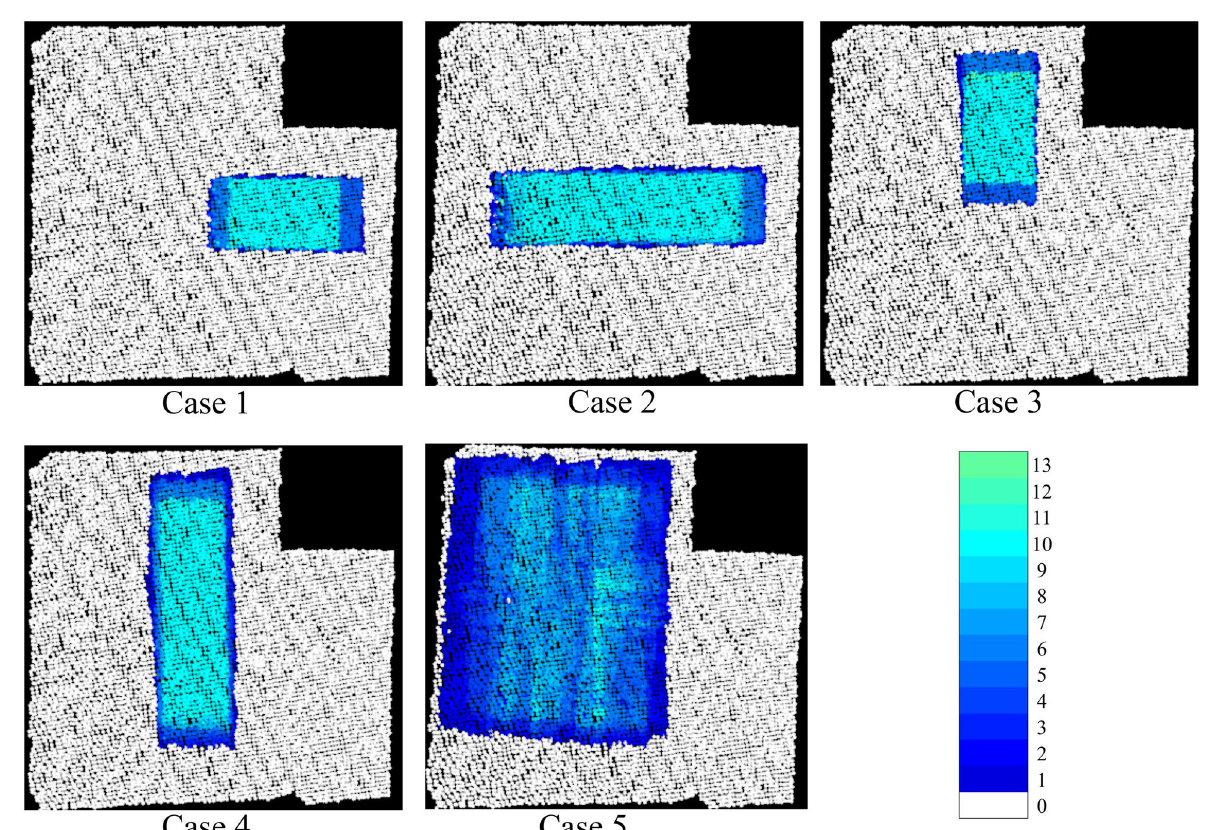
Fig. 12 Generated swept maps. The number next to the color bar indicates the number of times the area was